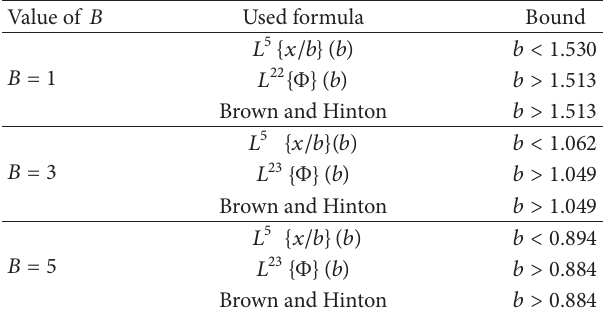
Table 2: Comparison of bounds for 𝑏 in Example 2.